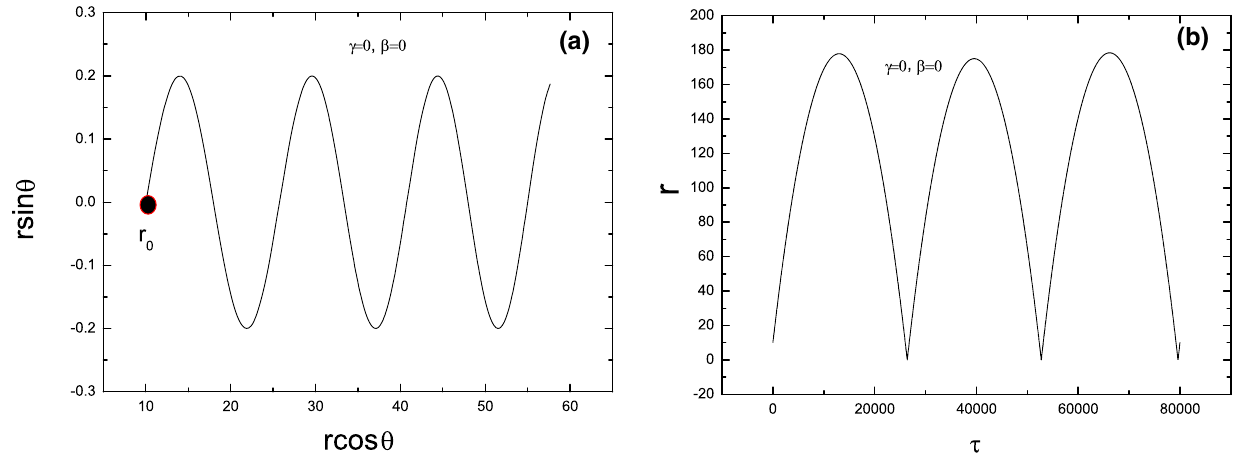
Fig. 1 The string trajectory around the massive body with γ = 0 and β = 0, for which B ( r ) = 1 is independent of r and the horizon is absent. Here, we set E = 12, α = 1 /π and the initial conditions as r 0 = 10, θ 0 = 0, p θ